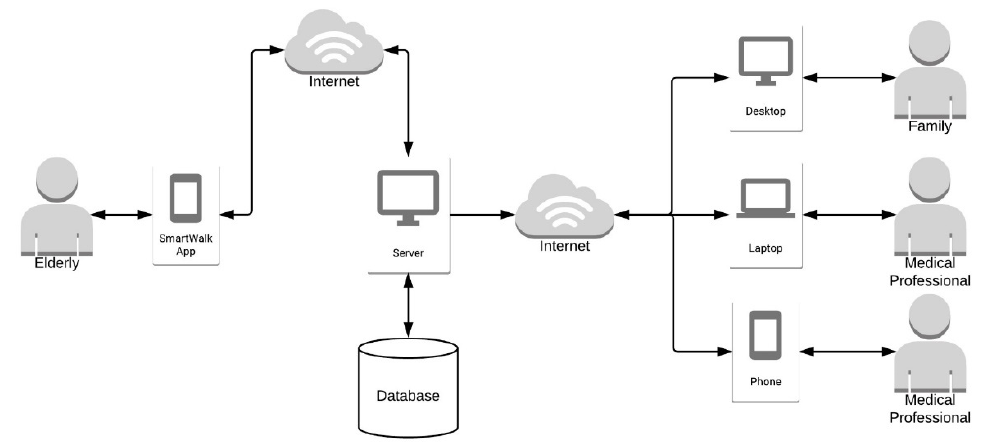
Figure 1. SmartWalk architecture.